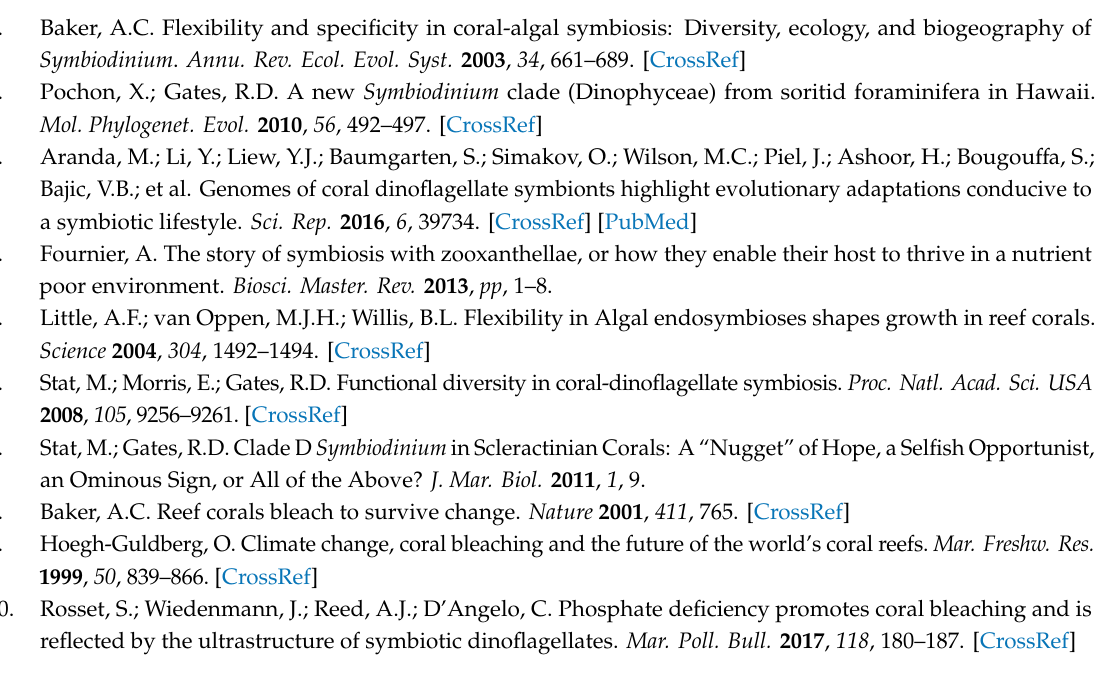
Table S1. Information of core genes commonly expressed under all the four culture conditions (heat stress, control, P-depleted and DOP replacement) in F. kawagutii , Table S2: Information of di ff erentially expressed genes in response to heat stress in F. kawagutii , Table S3. Information of di ff erentially expressed genes in response to phosphorus stress in F. kawagutii , Table S4. Information of di ff erentially expressed genes in response to dissolved organic phosphorus (DOP, glycerophosphate) replacement in